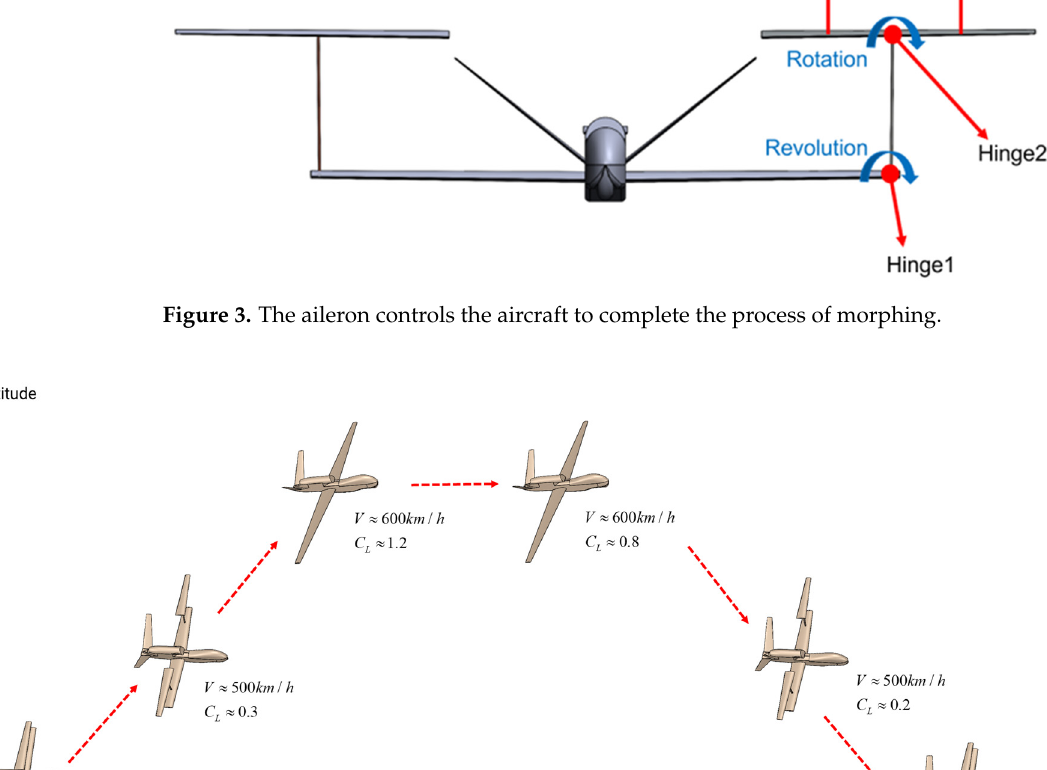
Figure 3. The aileron controls the aircraft to complete the process of morphing.